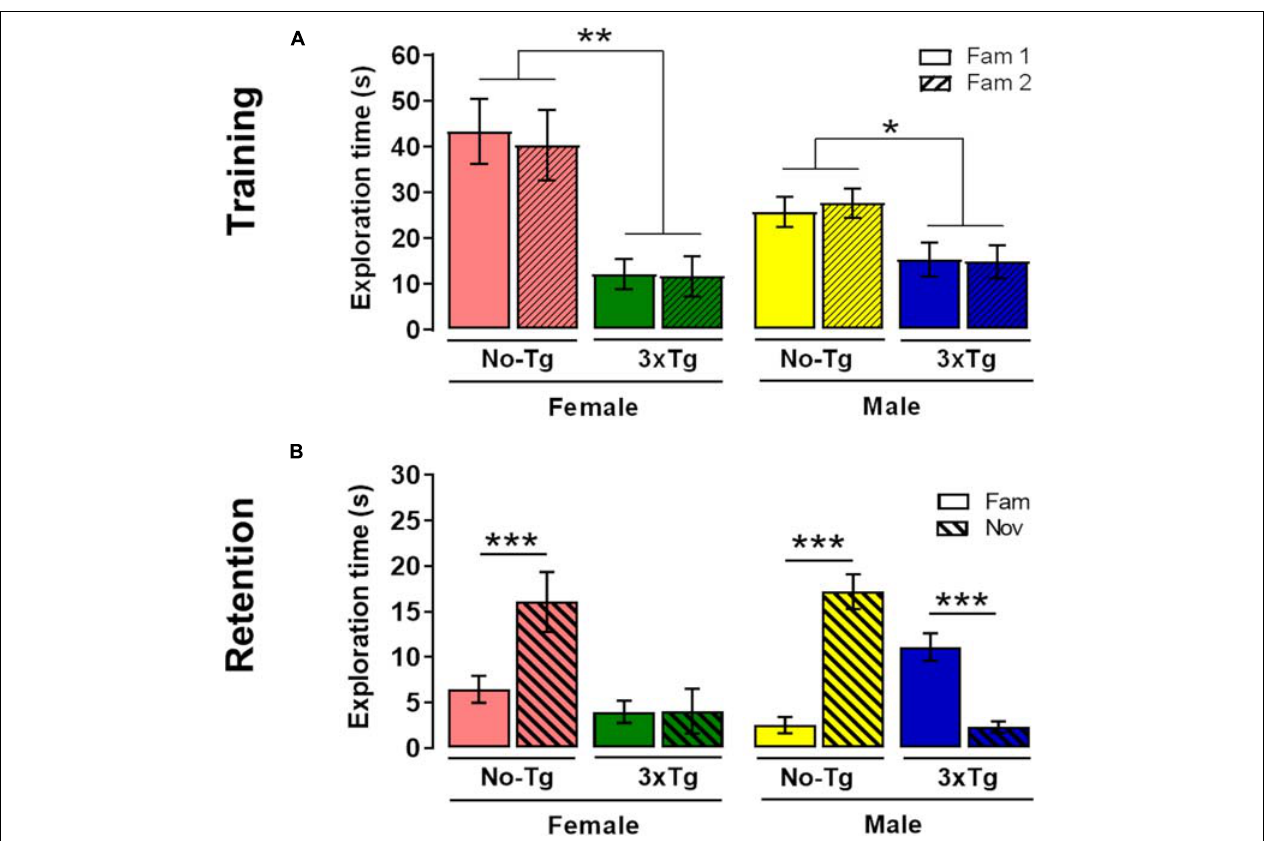
FIGURE 3 | Novel-object localization (NOL) task. Mean exploration time (with standard error) of familiar localization 1 (Fam 1) and familiar localization 2 (Fam 2) in (A) training and exploration time of familiar localization (Fam) and novel localization (Nov) in (B) retention test of female or male non-transgenic (NoTg) or Alzheimer’s disease triple-transgenic (3xTg-AD) mice of 5 months old. * p < 0.05, ** p < 0.001, *** p < 0.0001; n = 10 mice per group.